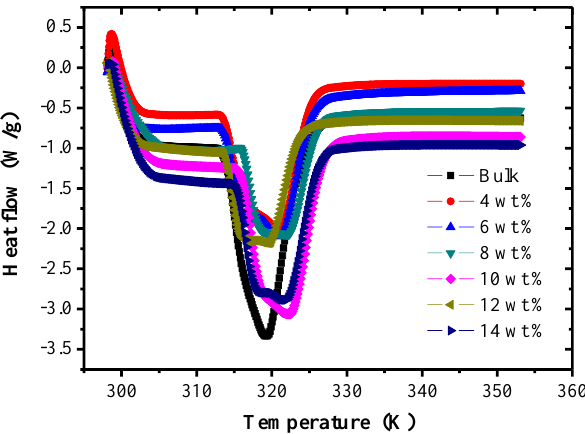
Figure 4. Differential scanning calorimeter (DSC) thermogram of chopped carbon fiber reinforced TPI shape memory polymer composites with different mass fractions.